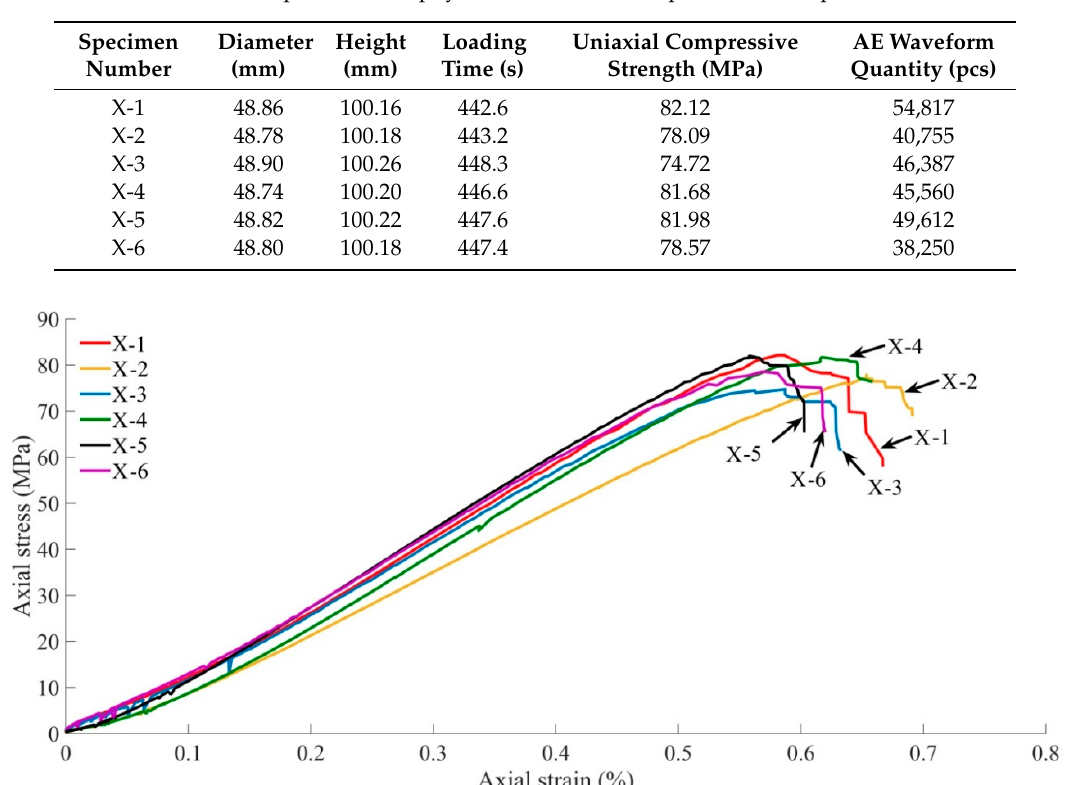
Figure 2. Axial stress–strain curves of specimens.